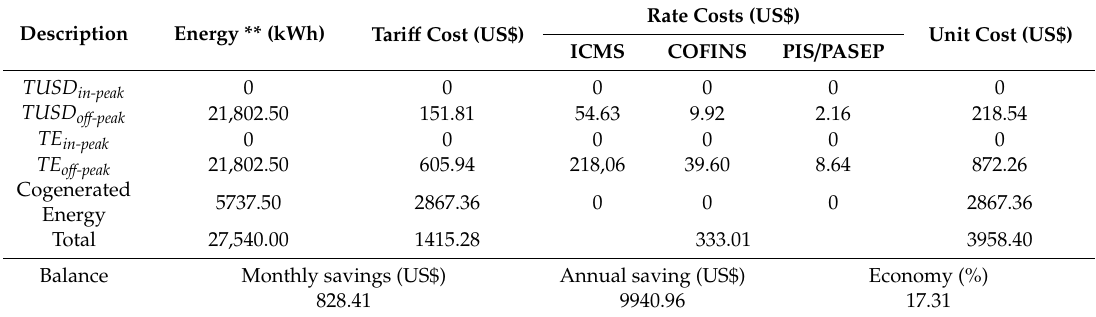
Table 6. Energy costs according to the smart grid project of company A, combining White Tari ff and generator set for company A *.